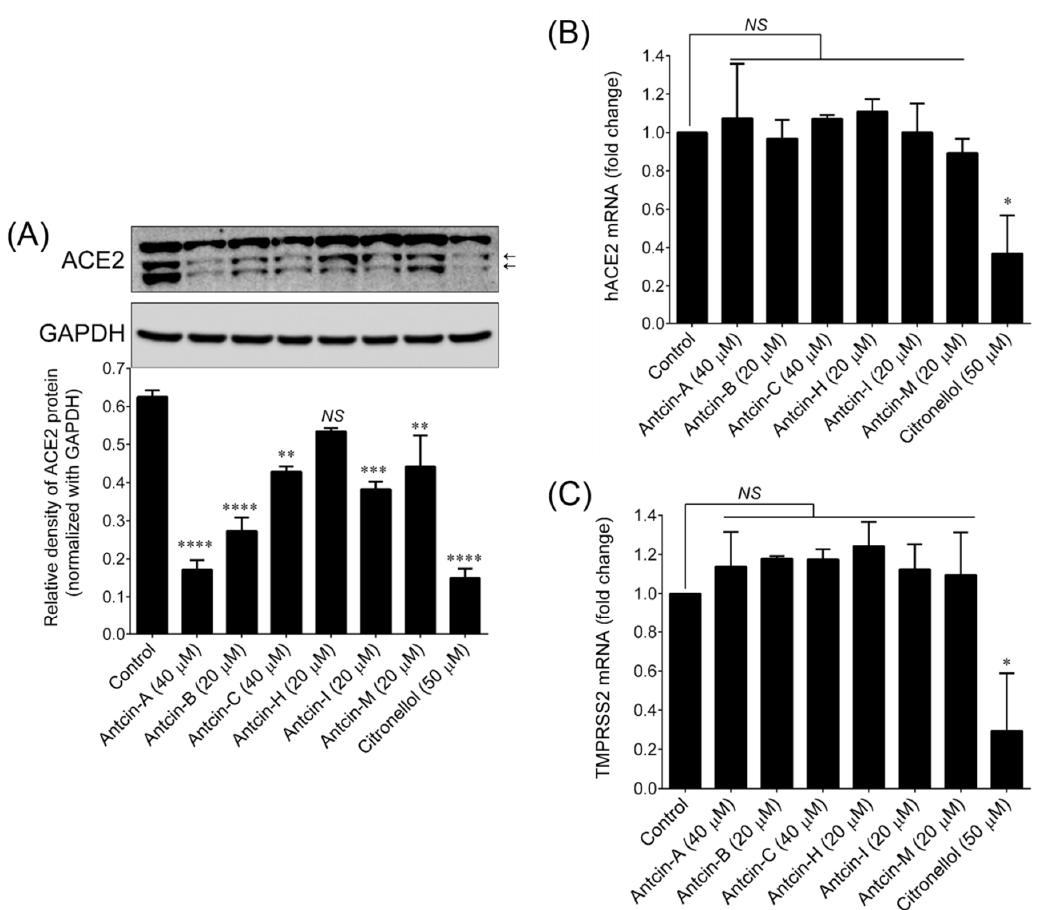
Figure 4. Antcins inhibited ACE2 protein expression in HT-29 cells. ( A ) HT-29 cells were incubated with the indicated concentration of antcins for 48 h. Protein expression levels of ACE2 was determined by immunoblotting. Glyceraldehyde 3-phosphate dehydrogenase (GAPDH) was used as an internal loading control. The relative density of one representative experiment is shown, where ACE2 signal was normalized with GAPDH signal. ( B , C ) Relative expression of ACE2 and TMPRSS2 mRNAs in HT-29 cells. Total RNA was extracted from cells treated with indicated concentration of antcins for 48 h. The transcription levels of ACE2 and TMPRSS2 were quantified by qPCR and a representative experiment is shown. The ∆ ct values of ACE2 and TMPRSS2 mRNAs were normalized to GAPDH mRNA. Values represent the mean ± SD of two independent experiments. p -values of less than 0.05 *, 0.01 **, 0.001 ***, and 0.0001 **** were considered statistically significant for the antcins treatment group vs. the control group.